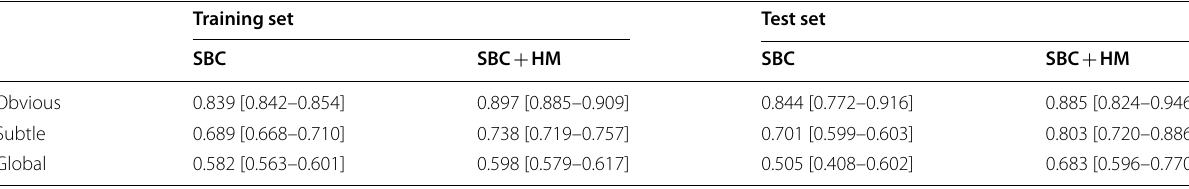
Table 1 AUCs for malignancy probability scores for the SBC and SBC group of normal mammograms. This is calculated for the training set and the test set separately. Square brackets contain the lower and upper bands of 95% CIs